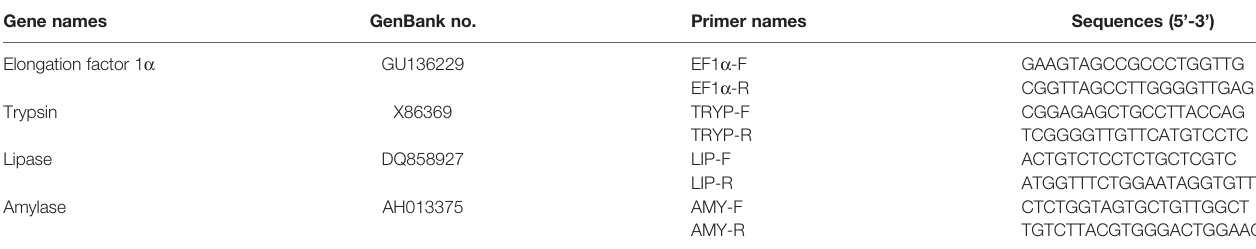
TABLE 2 | Primers used for quantitative real-time